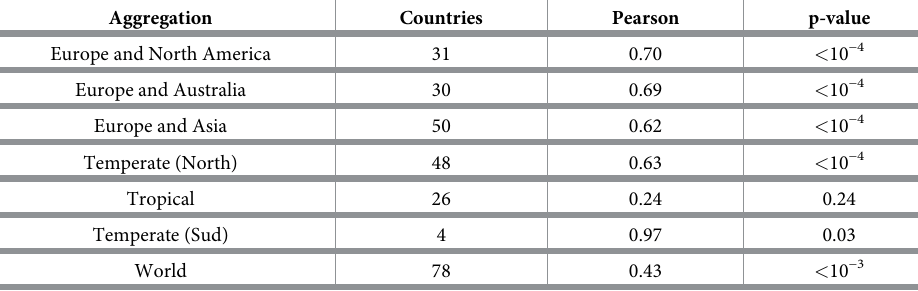
for different continent T